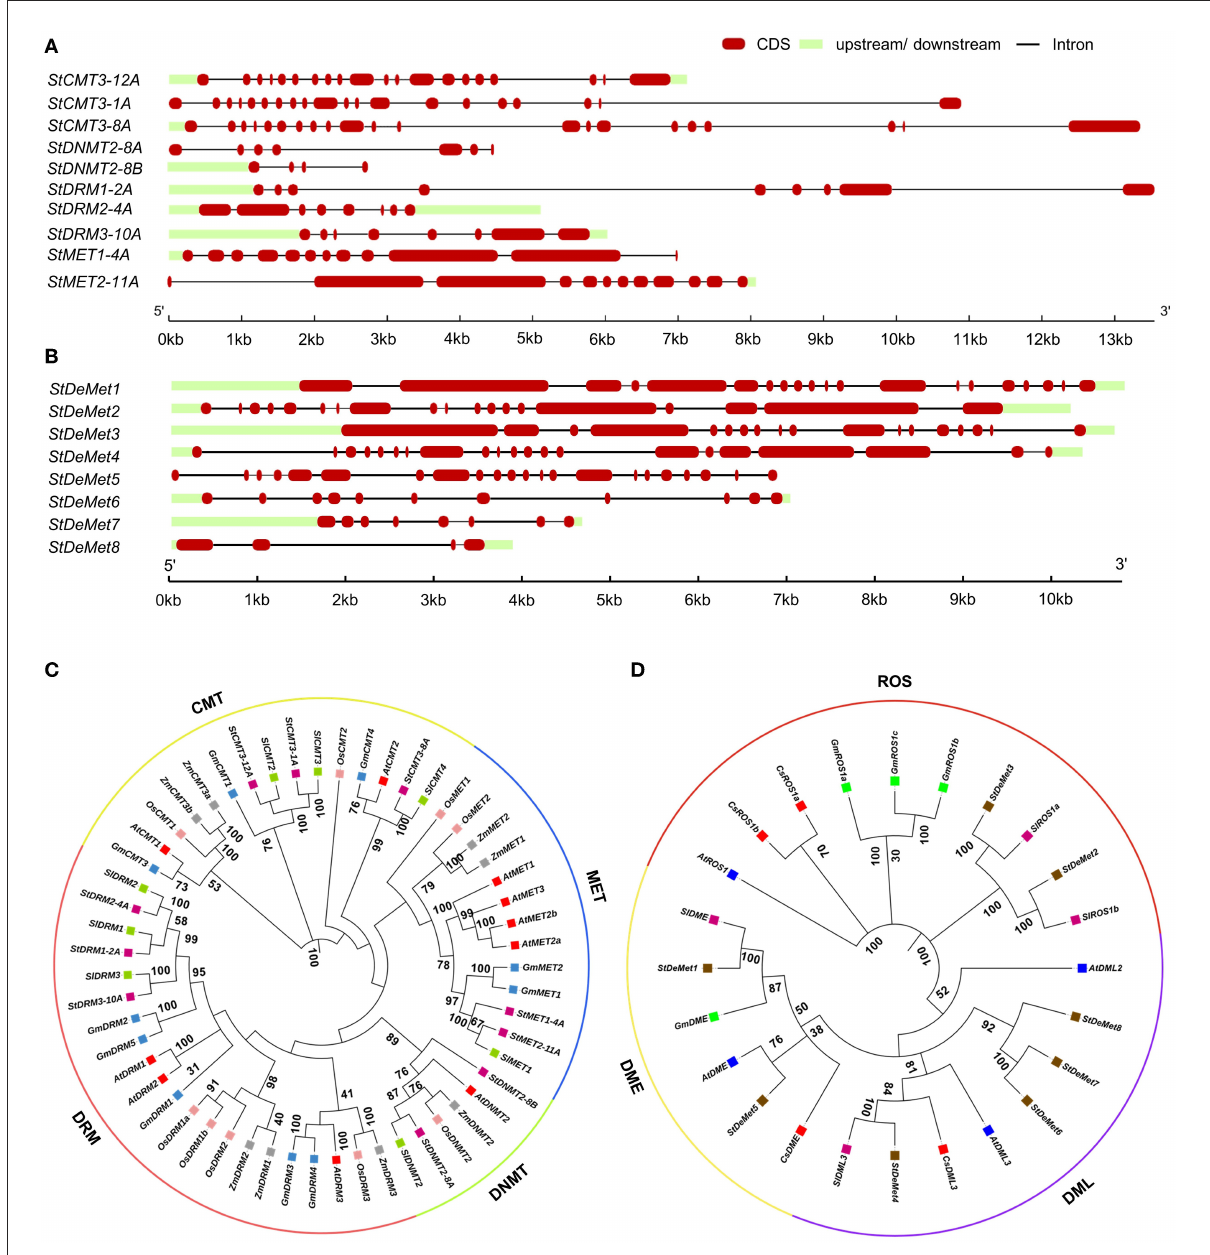
FIGURE1 Gene structures of StC5-MTase (A) and StDeMets (B) in S. tuberosum. Phylogenetic tree analysis of C5-MTase (C) and DeMet proteins (D) with 1,000 bootstrap replicates. The lines in gene structure represent introns and filled red and light green boxes represent CDS and UTR, respectively. The lengths of CDS and introns can be determined using the scale bar on the bottom.